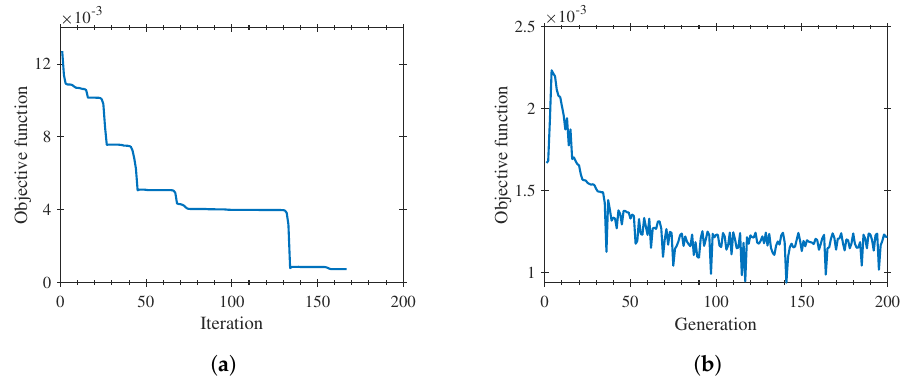
Figure 16. History of the objective function through the iterative optimization process using ( a ) SQP algorithm. ( b ) NSGA-II